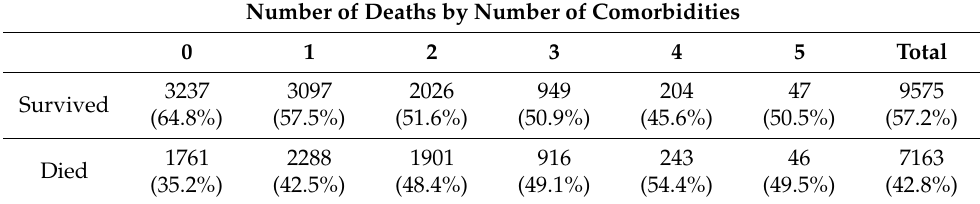
Table 4. Association between deaths and number of multimorbidities in a series of patients from Hidalgo, Mexico. Number of Deaths by Number of